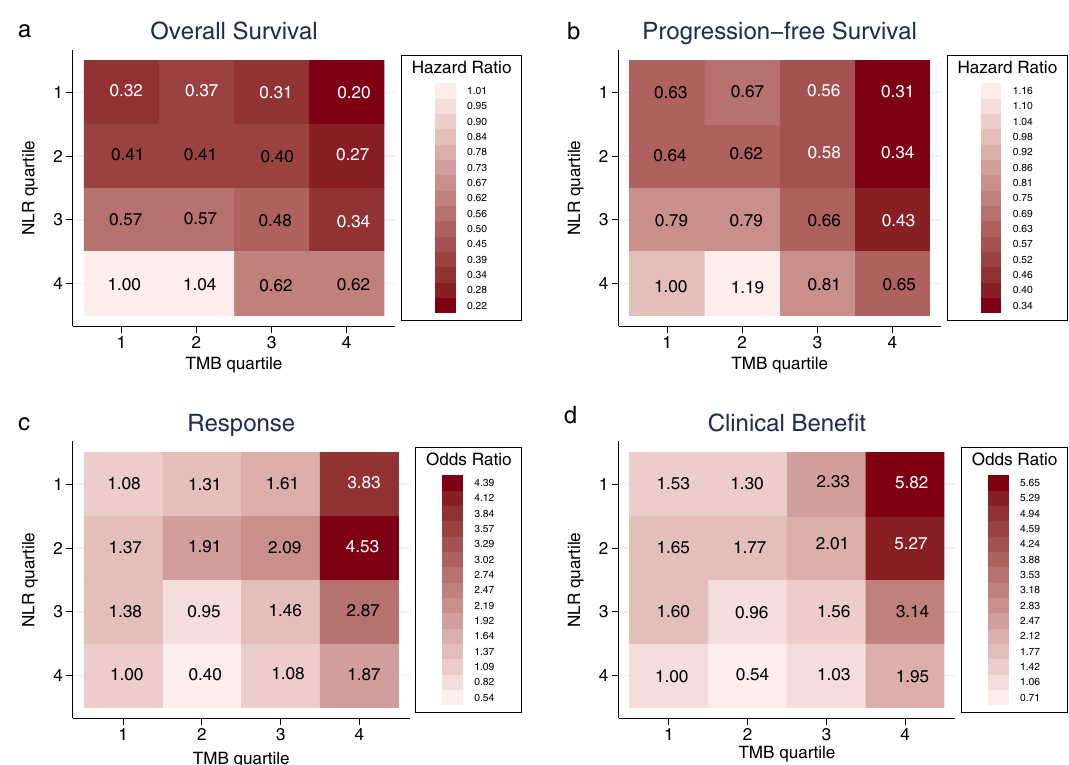
Fig. 4 Outcomes across quartile-based categories of neutrophil-to-lymphocyte ratio (NLR) and tumor mutational burden (TMB). Heat maps of hazard ratios (HRs) for a overall survival and b progression-free survival, and heat maps of odds ratios (ORs) for c response and d clinical bene fi t based on 16 within cancer type quartile-based categories of NLR and TMB. HRs were calculated with Cox proportional hazard regression. ORs were calculated with logistic